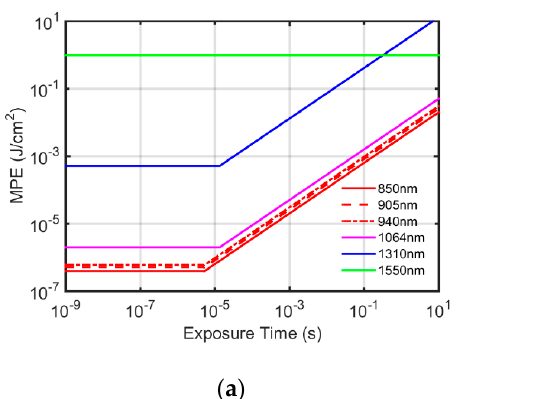
Table 3. A comparison of typical designs and properties between Si and SiN waveguide with SiO 2